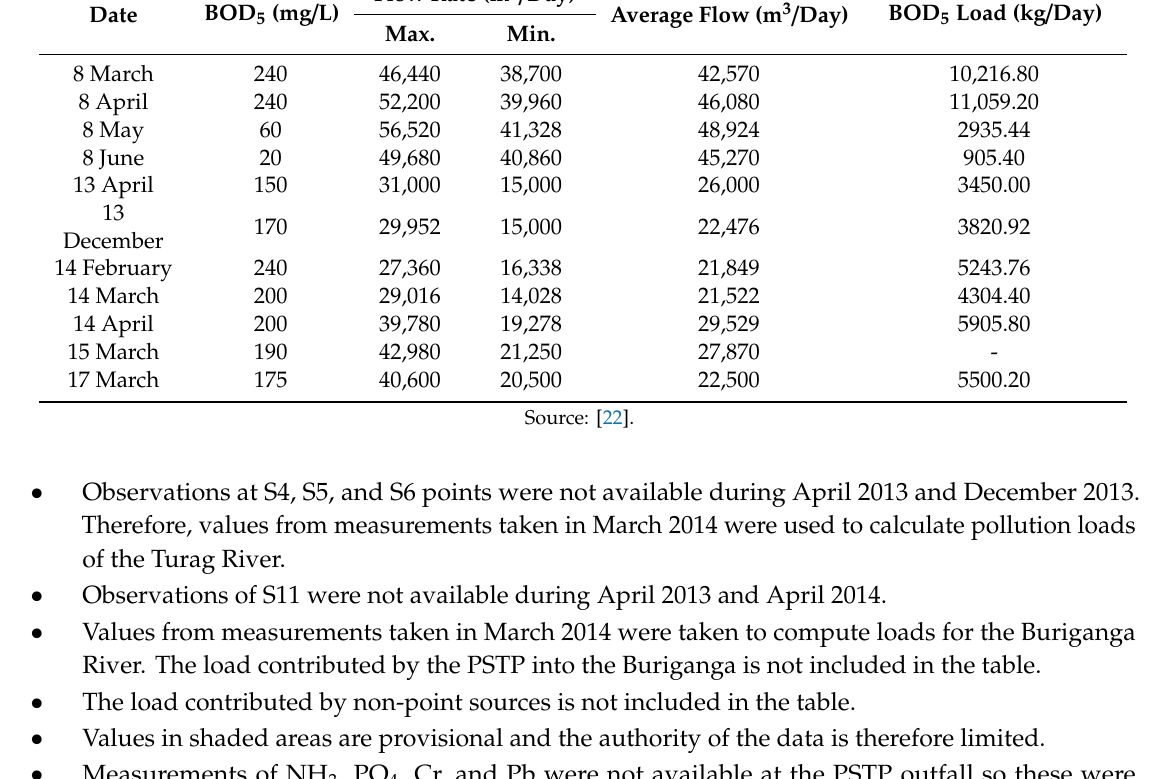
Table A1. BOD load discharged into the Buriganga from PSTP treatment plant. Flow Rate (m 3 / Day) BOD 5 (mg / L) Average Flow (m 3 /